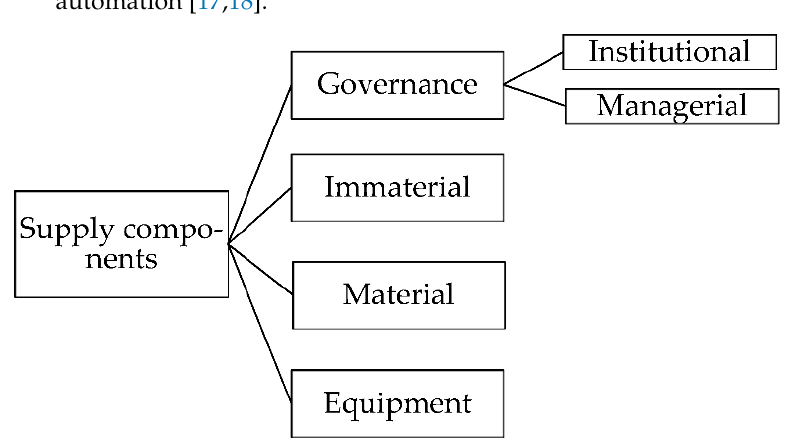
Figure 1. Transport supply components.